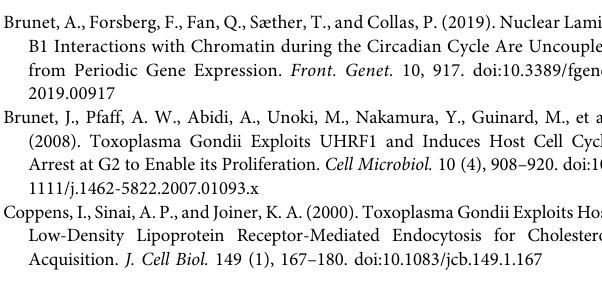
actin (Phalloidin: green; the image corresponds to the one shown in Figure 7A ). 3D reconstructionwasperformedbyNISelementsoftwarebuilt-inplugins.Background and signal levels were equally adjusted to illustrate the actin cytoskeleton in both non-infected and N. caninum -infected